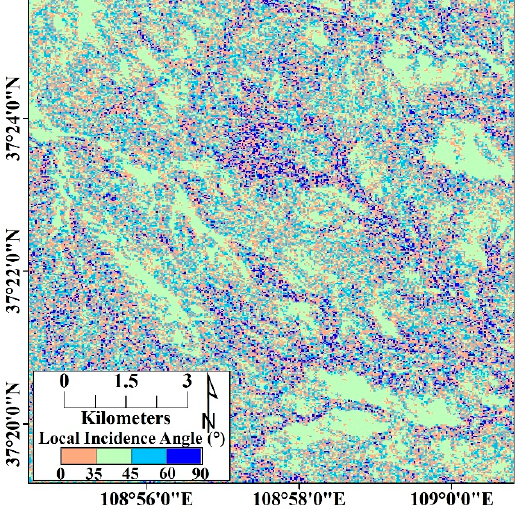
Figure 10. The map of local incidence angles in the study area inverted based on IACM.